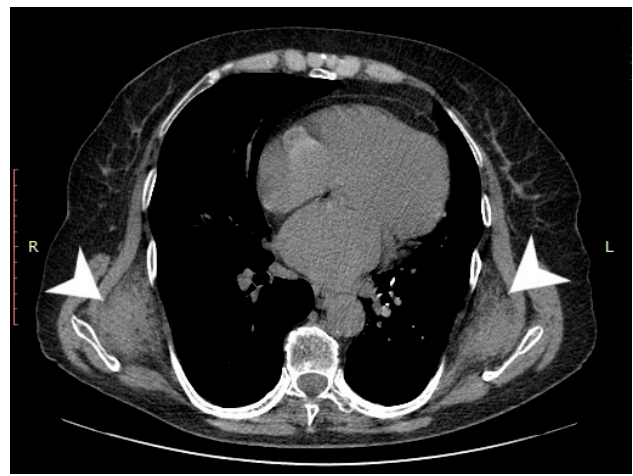
Figure 1. Axial CT view of the thoracic region at the level of the inferior third of the scapula. The tumoral masses are indicated by white arrows).